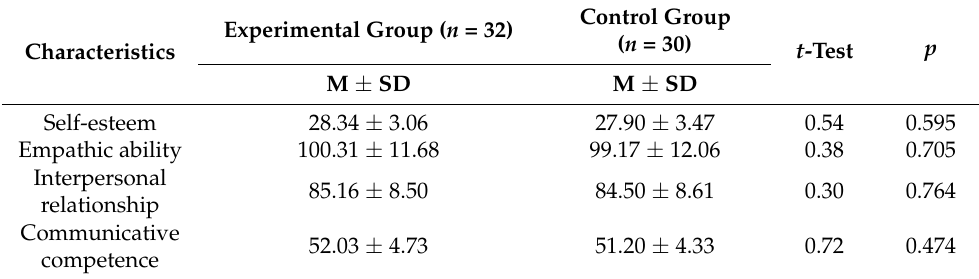
Table 3. Homogeneity of variables between the control and experimental group ( N = 62).